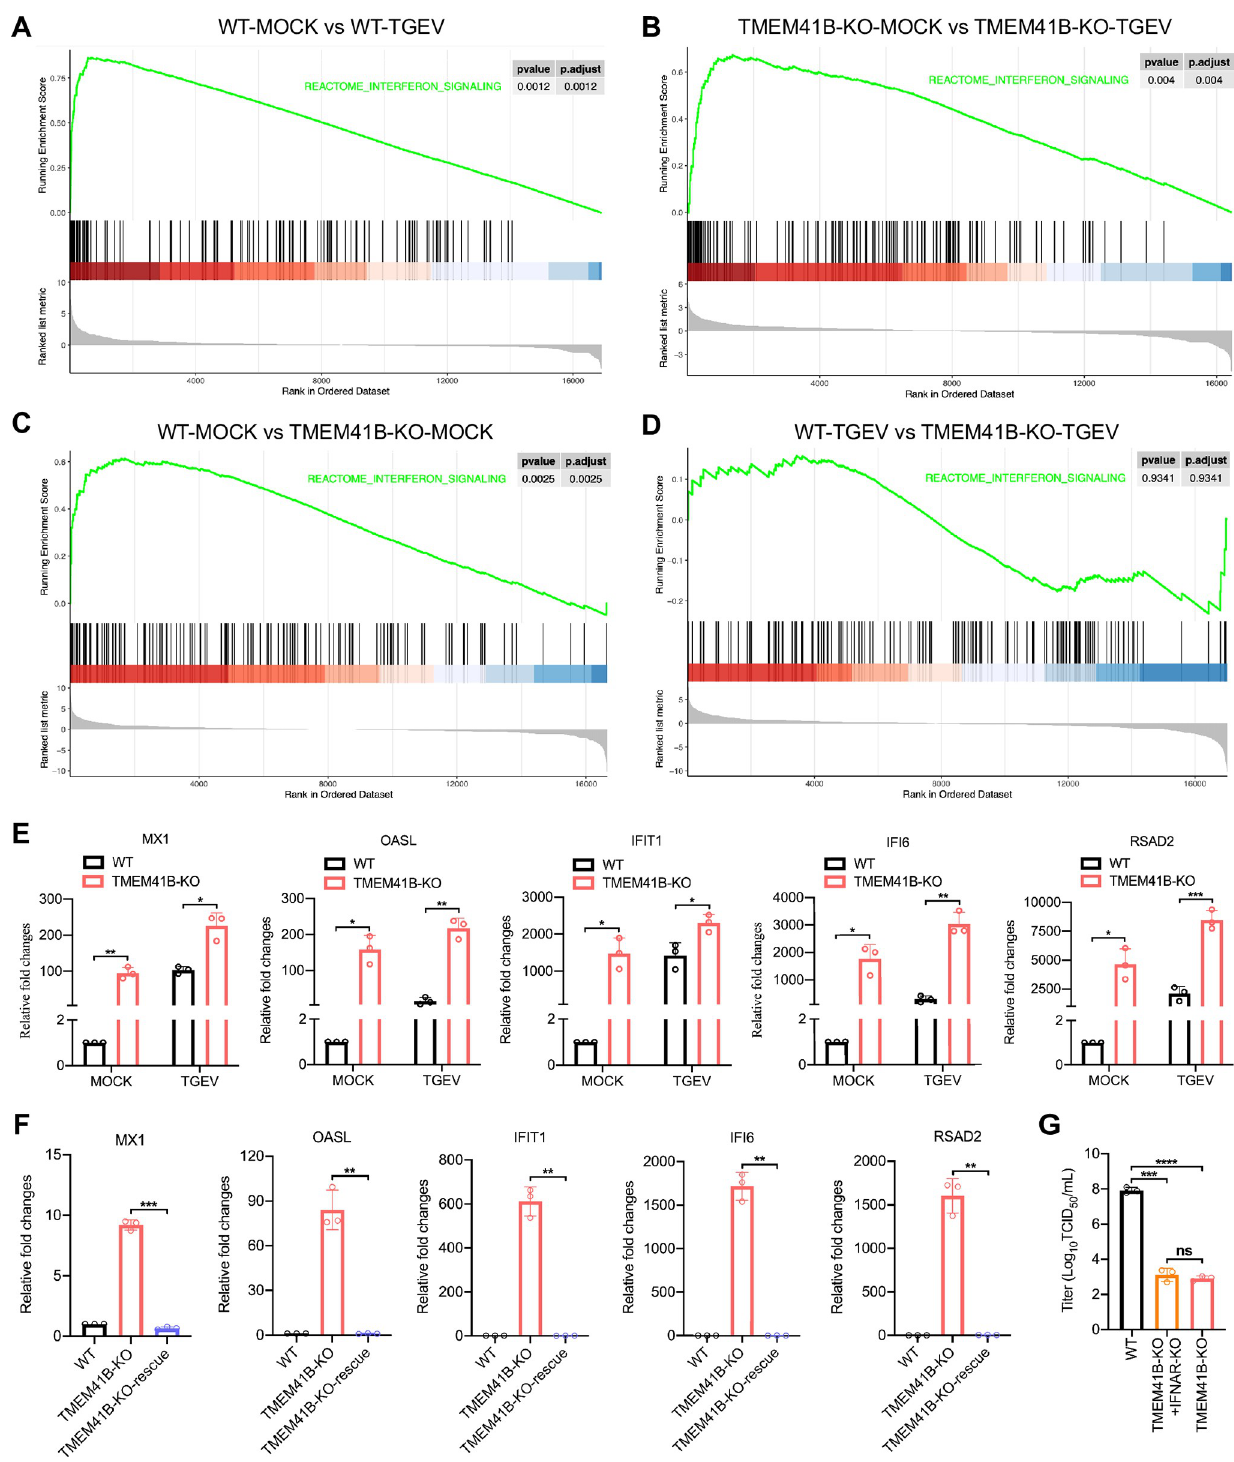
Fig 3. TMEM41B is an intrinsic negative regulator of innate immune responses. (A-D) Gene Set Enrichment Analysis (GSEA) for differentially expressed genes from the RNA-seq data shows a distinct upregulation of the interferon signaling pathway across the four pairwise groups (A) WT-MOCK vs WT-TGEV; (B) TMEM41B-KO-MOCK vs TMEM41B-KO-TGEV; (C) WT-MOCK vs TMEM41B-KO-MOCK; (D) WT-TGEV vs TMEM41B-KO-TGEV. (E) RT-qPCR validation of the mRNA expression of ISGs selected by RNA-seq results. (F) RT-qPCR outcome reveal that the stable rescue of TMEM41B in TMEM41B KO cells led to the significant suppression of genes associated with the interferon signaling pathway. (G) Viral